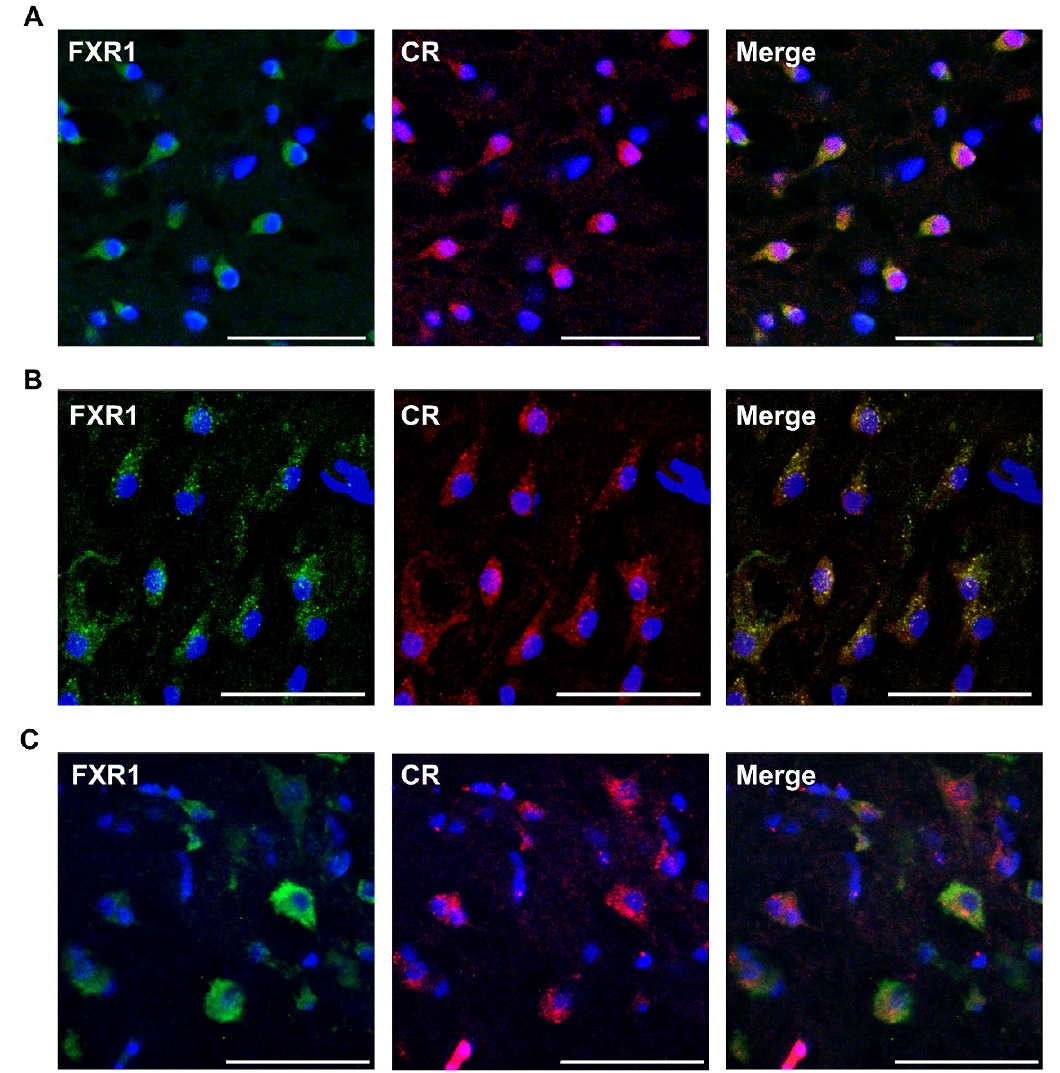
Figure 3. Colocalization of FXR1 (green signal) with amyloid-specific dye CR (red signal) in neu- rons of frog ( A ), turtle ( B ), and chicken ( C ). Blue signal corresponds to the nuclear dye DAPI; scale bar is 50 µm.